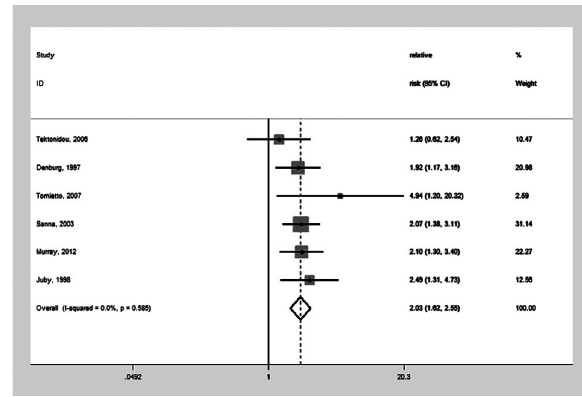
Figure 3. Forest plot for meta-analysis of the studies addressing the presence of antiphospholipid antibodies and cognitive dysfunction or dementia (Odds Ratio=2.03)